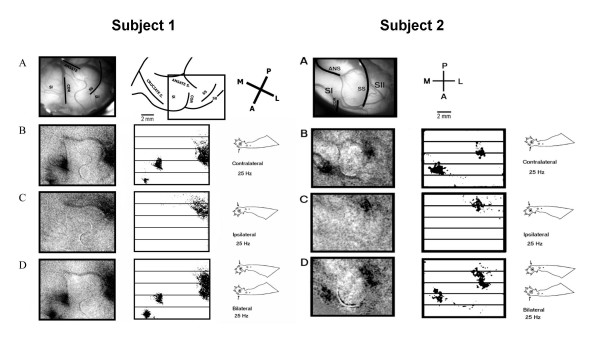
Cat SI and SII optical responses to 25 Hz vibrotactile stimulation of the forepaws (2 subjects). A. View of the cortical surface, showing the vascular pattern and coronal (COR), ansate (ANS), and suprasylvian (SS) sulci. Exposed portions of SI and SII are indicated. Left hand column of Subject 1 and Subject 2 : Averaged difference images for responses evoked by (B) contralateral, (C) ipsilateral and (D) bilateral stimuli. Adjacent thresholded images of responses evoked by the three modes of stimulation – horizontal grid lines facilitate comparison of the position of loci of the evoked responses and are spaced 2 mm apart. Stimulus sites are indicated by figurines. Note that in both subjects, ipsilateral stimulation evokes a response posterior to the response evoked by contralateral stimulation. Scale bar is 2 mm. Orientation of images indicated by P (posterior), A (anterior), M (medial) and L (lateral) axes.